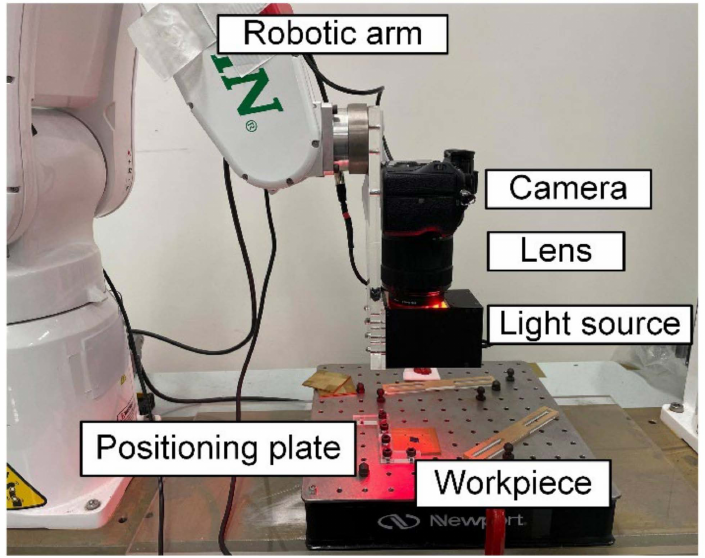
Figure 2. The setup of images acquisition system to take photos of the ground